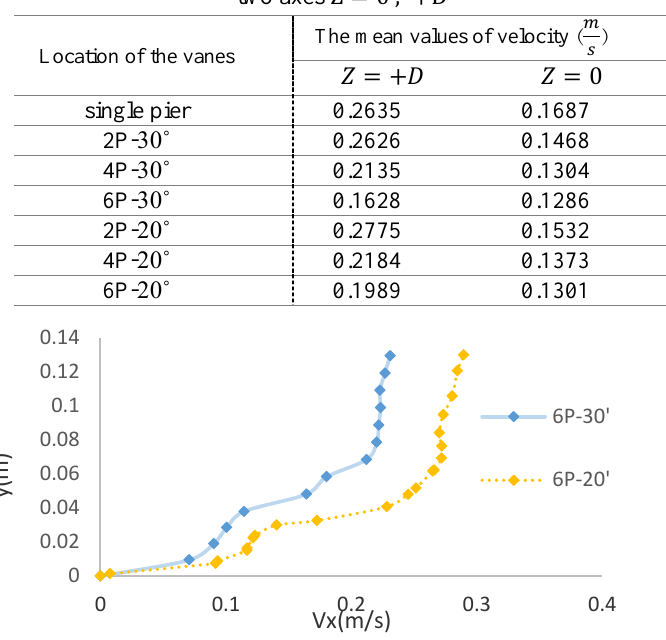
Fig 14. Comparison of the angle of submerged vanes in 𝛼 = 20˚ , 𝑍 =